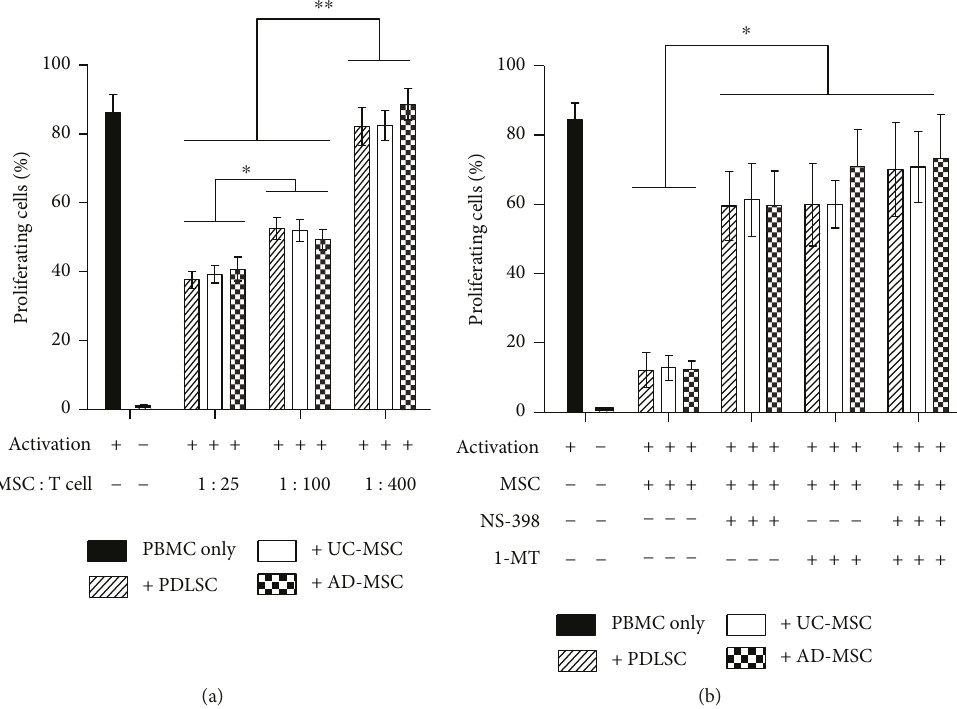
Figure 3: (a) Dose-dependent inhibition of activated PBMC proliferation by MSCs. PBMCs isolated from healthy donors were labeled with CFSE, stimulated with anti-CD3/anti-CD28 antibody-coated beads, and cocultured with naive MSCs at MSC :PBMC ratios of 1 :25, 1 :100, or 1:400 for 3.5 days. Proliferating cells were analyzed by fl ow cytometry, and the percentage of each experimental group is represented as a bar on the histogram. (b) Recovery of PBMC proliferation by inhibitors of IDO or COX-2. Identical experiments were performed as those in (a) at an MSC :PBMC ratio of 1:10 in the presence of the IDO inhibitor 1-methyl- L -tryptophan (1-MT, 0.1mM), the COX-2 inhibitor (NS-398, 0.1mM), or both. Flow cytometric pro fi les are shown in Supplementary Figure 2. All experiments were performed independently at least three times. The graph shows the means and standard errors of the mean (SEMs). p values were obtained by ANOVA followed by Tukey ’ s post hoc test. ∗ p < 0 05 and ∗∗ p < 0 01